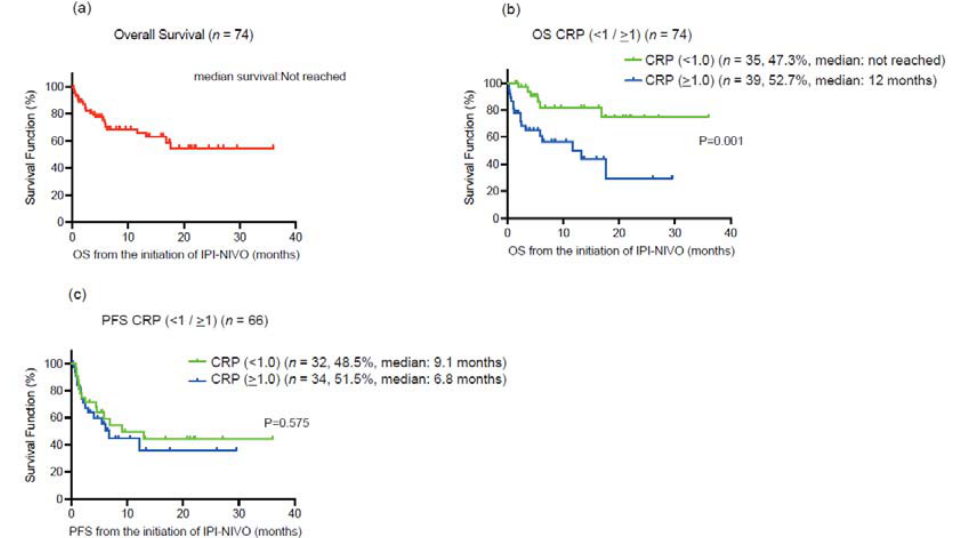
Figure 2. ( a ) Kaplan–Meier curve for overall survival (OS) in all 74 metastatic renal cell carcinoma (mRCC) patients treated with ipilimumab plus nivolumab. ( b ) Kaplan–Meier curves for overall survival (OS) according to the cut-off of serum C-reactive protein (CRP) 1.0 mg/dL. ( c ) Kaplan–Meier curves for progression-free survival overall survival (PFS) according to the cut-off of serum C-reactive protein (CRP) 1.0 mg/dL.